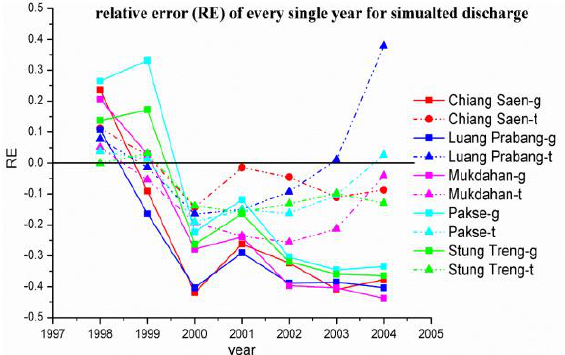
Figure.2 Comparison of RE of site-driven and remote-sensing driving simulation results